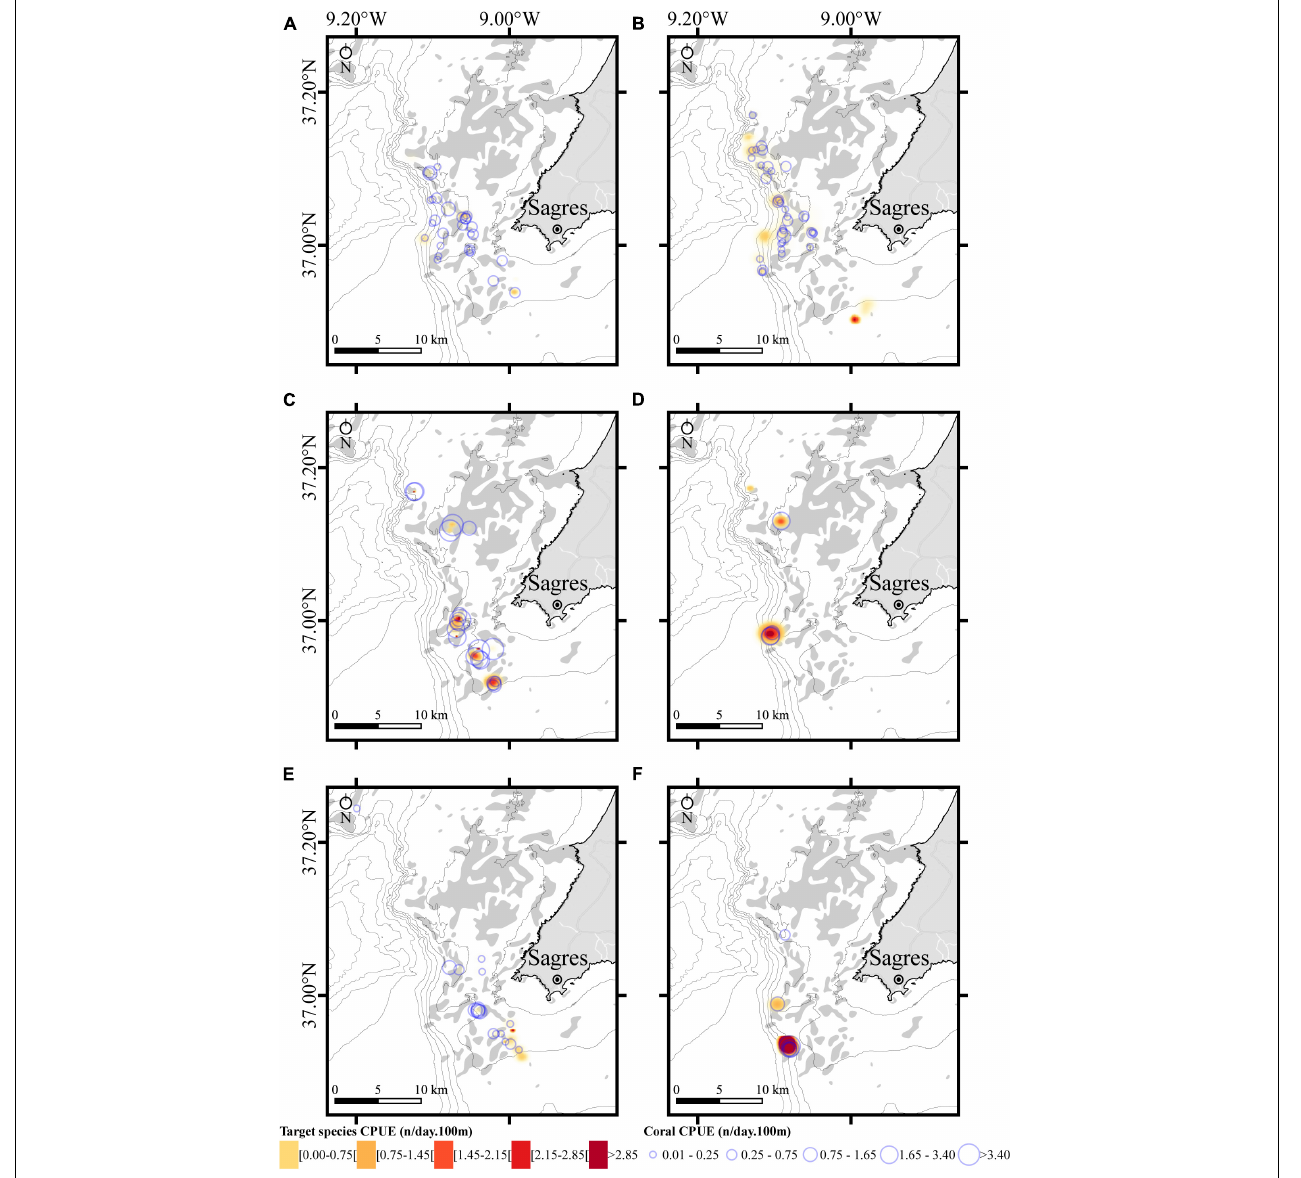
FIGURE 5 | Spatial distribution of the fishing effort for target species and coral bycatch in bottom-set gillnets off the coast of Sagres (Portugal) during the summer-autumn (left panels) and spring (right panels) sampling seasons. Fishing effort was calculated as the catch per unit of effort (CPUE) and represents the number of specimens (fish/lobster or coral) as a function of the product of the net soaking time (days) and 100 m of net length deployed. (A,B) Lophius budegassa; (C,D) Zeus faber; (E) Raja brachyura, Palinurus elephas, Palinurus mauritanicus pooled; and (F) Palinurus elephas and Polyprion americanus pooled. The maps in E and F show seasonally deployed nets for species that are targeted over specific periods of the year. CPUEs for the target species are displayed as heatmaps generated using triweight kernel density and corals displayed as bubbles. Bathymetric isobaths are as follows: 50 m, 100–500 m (increments of 100 m), and > 500 m (increment of 200 m). Rocky substrate is represented as gray